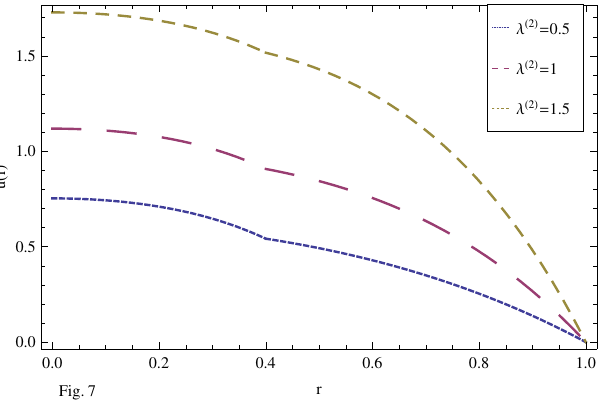
Figure 7. Effect of λ ( 2 ) on the velocities of the two